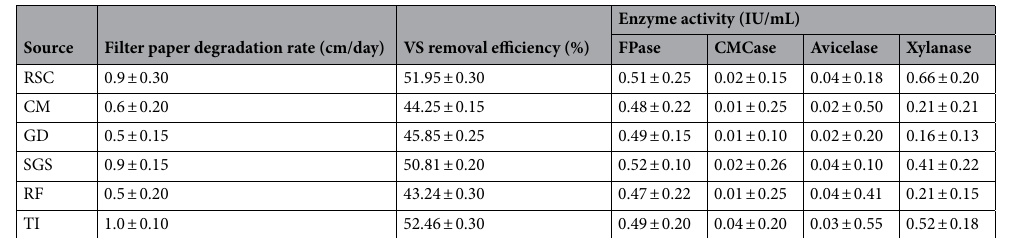
Table 2. Degradation efficiency and enzymatic activity of various microbial sources in the primary selection a . a All the data in each microbial source was measured when the filter paper complete degradation.